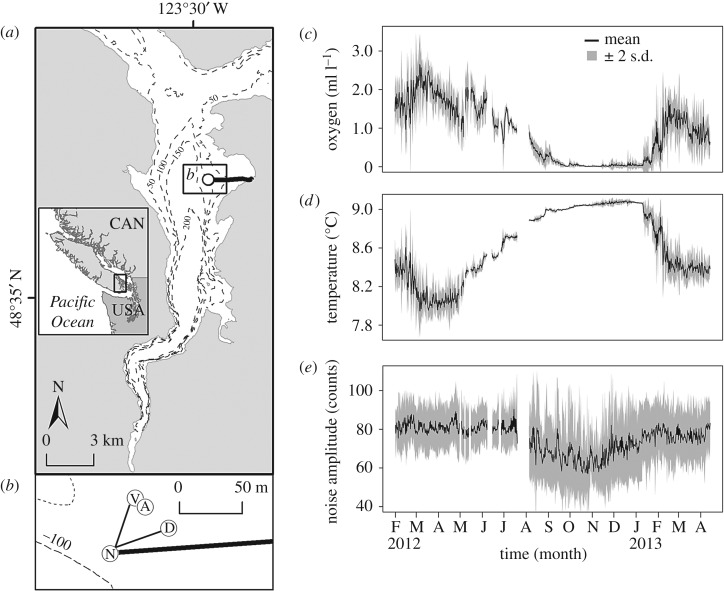
Observatory instrumentation in Saanich Inlet. (a) Saanich Inlet is located on Vancouver Island, British Columbia (inset). A surface-to-site power cable (black line) connects to VENUS subsea instrumentation (white circle) at a depth of 96 m. Contours are 50 m intervals. (b) The central node (site N) is the interface for power and communication to the main VENUS instrument platform (VIP; site V) and the DISCo camera array (site D), both located at 95 m. The Aquadopp current meter (site A) measuring backscatter is tethered to the VIP. (c–e) In situ VENUS data capture the magnitude of environmental variability over the annual hypoxia cycle. Data are the mean (black line) ± 2 s.d. (grey band) summarized to match the 12-h interval between imagery timestamps and were calculated from original raw per minute VENUS data. (c) Dissolved oxygen and (d) temperature were measured at 0.3 m above bottom at site D. (e) Backscatter was measured at 1 m above bottom using the return signal strength (noise amplitude) from beam 1 of the current meter at site A.